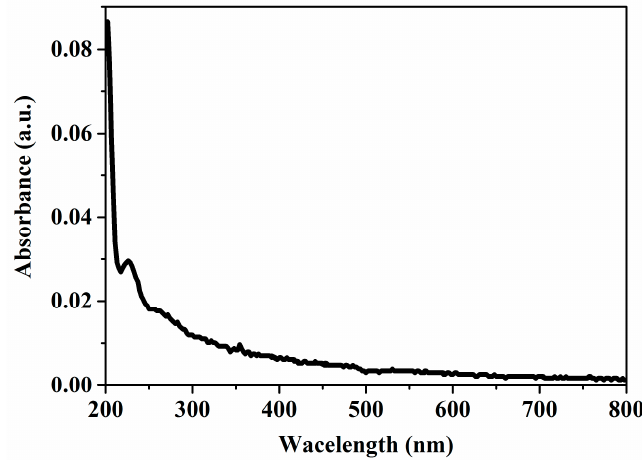
Figure 3. Absorption spectra of ZrIPO film on quartz glass.